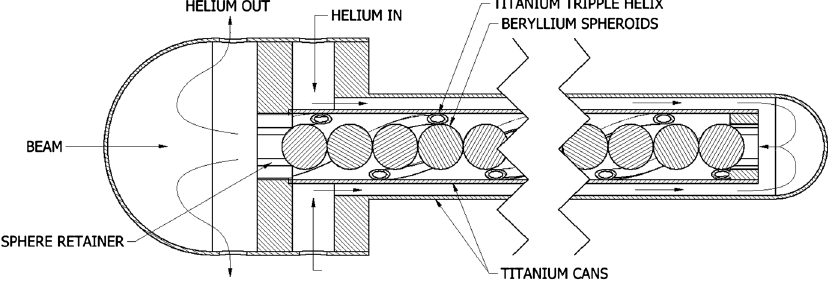
FIG. 4. Schematic diagram of proposed super beam spherical array